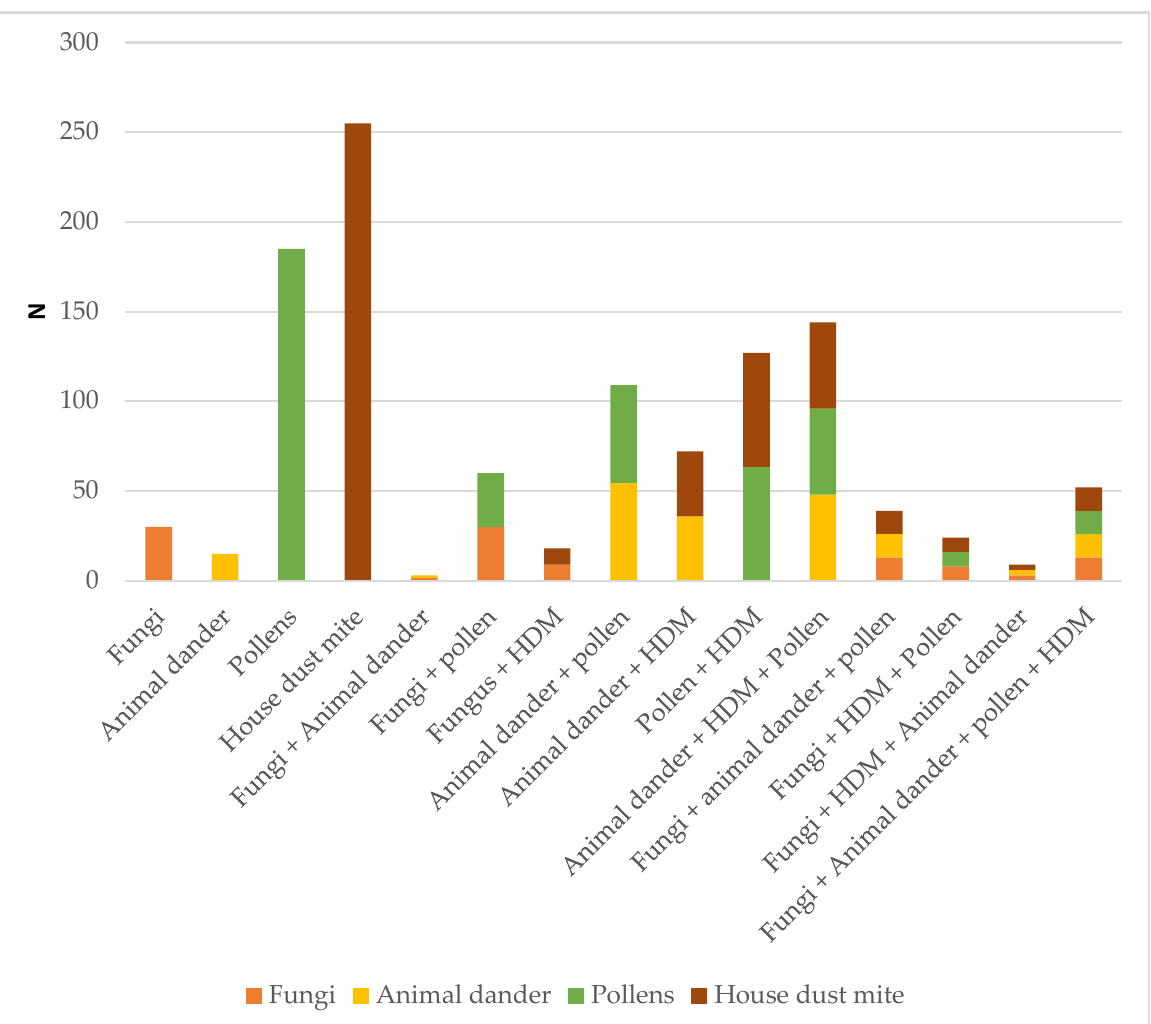
Figure 3. Polysensitization of the study population by allergen groups. Among the patients sensitized to any of the fungi tested (233); 214 patients had allergic rhinitis; description of these patients is below in Table 4. Table 4. Presence (%) of allergic rhinitis in sensitized patients to each fungal allergen. Fungus Sensitized ( n = 233) With Allergic Rhinitis ( n = 214)/% Alternaria alternata and Alt a 1 162 149/92% Cladosporium herbarum 31 31/100% Aspergillus fumigatus 45 43/95.5% Penicilium notatum 24